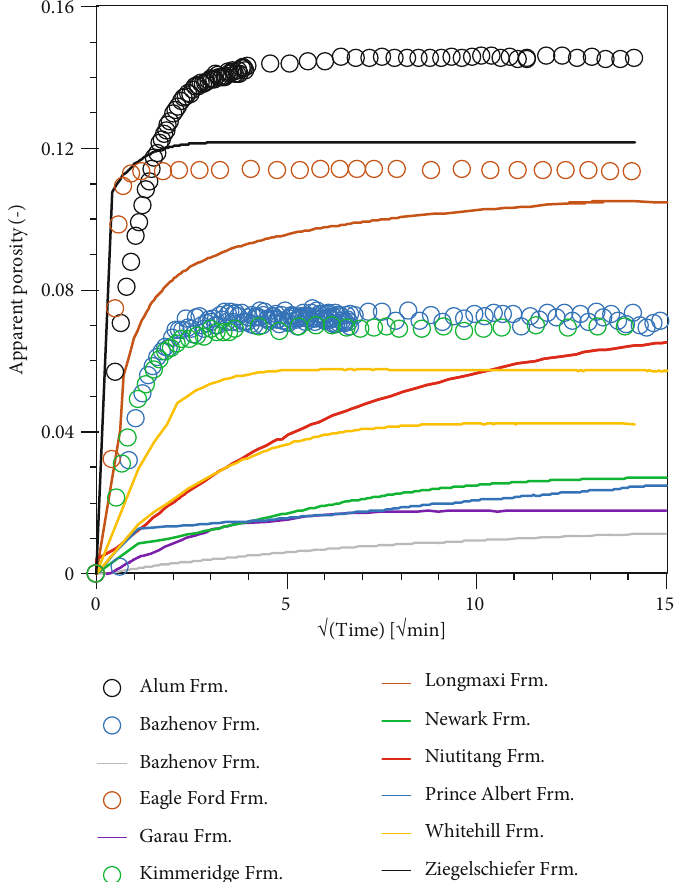
Figure 5: “ Apparent porosity ” calculated as a function of time during pressure equilibration in He pycnometry measurements for samples investigated in this study (dots) and additional samples (lines) studied previously. Equilibrium and di ff erential pressures were <